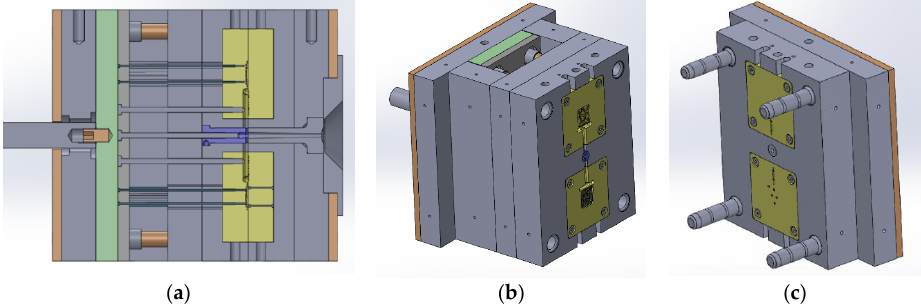
Figure 1. Half section view ( a ) and ¾ views of the movable ( b ) and stationary ( c ) sides of the mold used for the experiment.